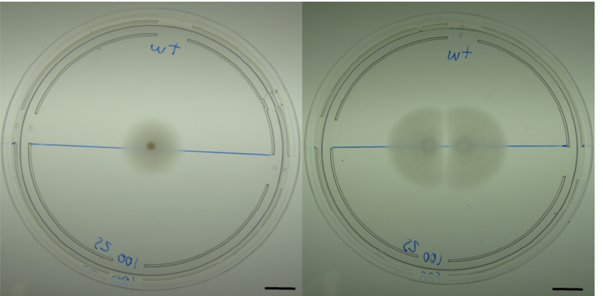
Figure 1. M. algicola DG893 growth on low percentage marine agar (0.25%) plates. The left pane shows growth of a single colony expanding by swarming while the right pane shows the growth of two sibling colonies placed a few centimeters apart, showing a clear zone of inhibition where the two colonies approach one another. Scale bar: 1 cm.